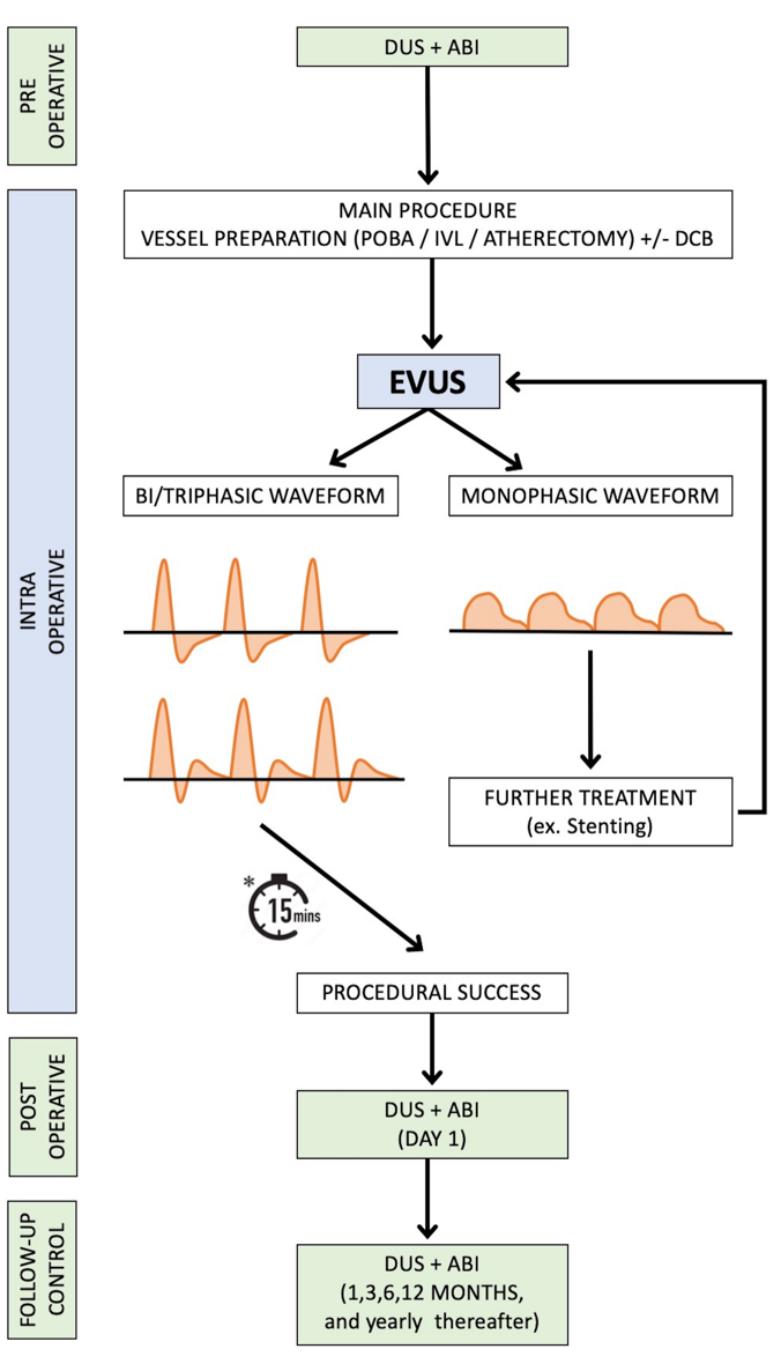
Figure 2. Diagnostic algorithm for peripheral arterial endovascular treatments and EVUS